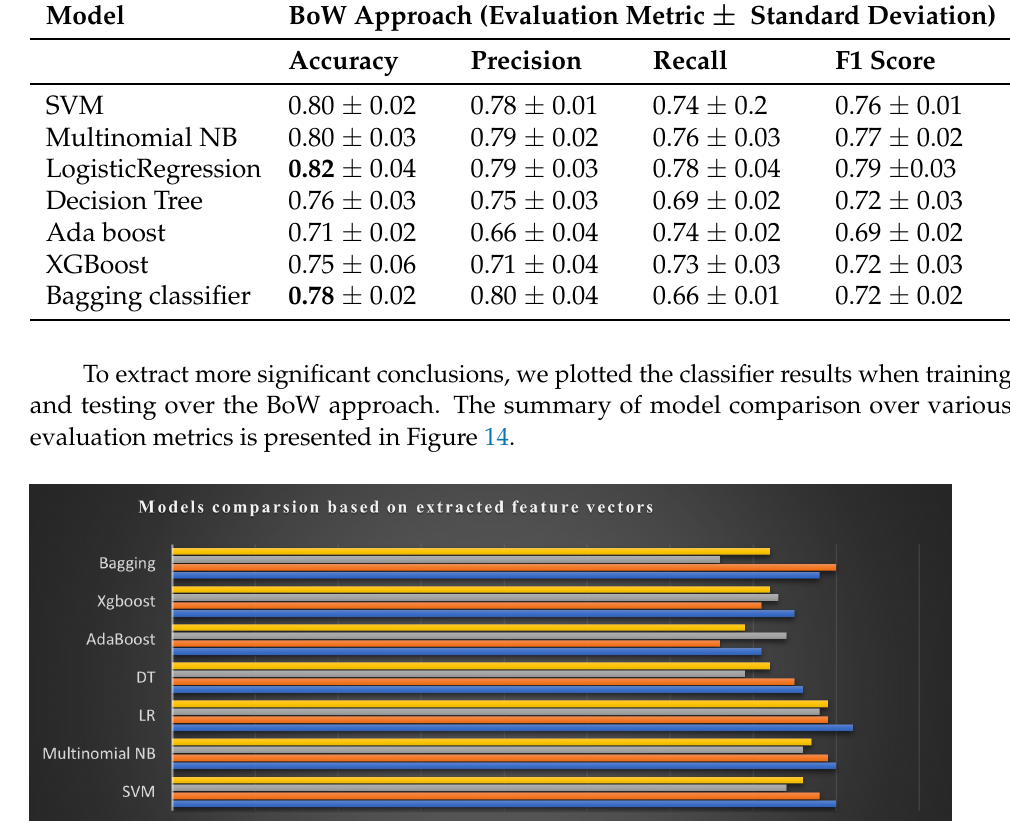
Table 7. Evaluation metric comparison of proposed models using BoW Approach.